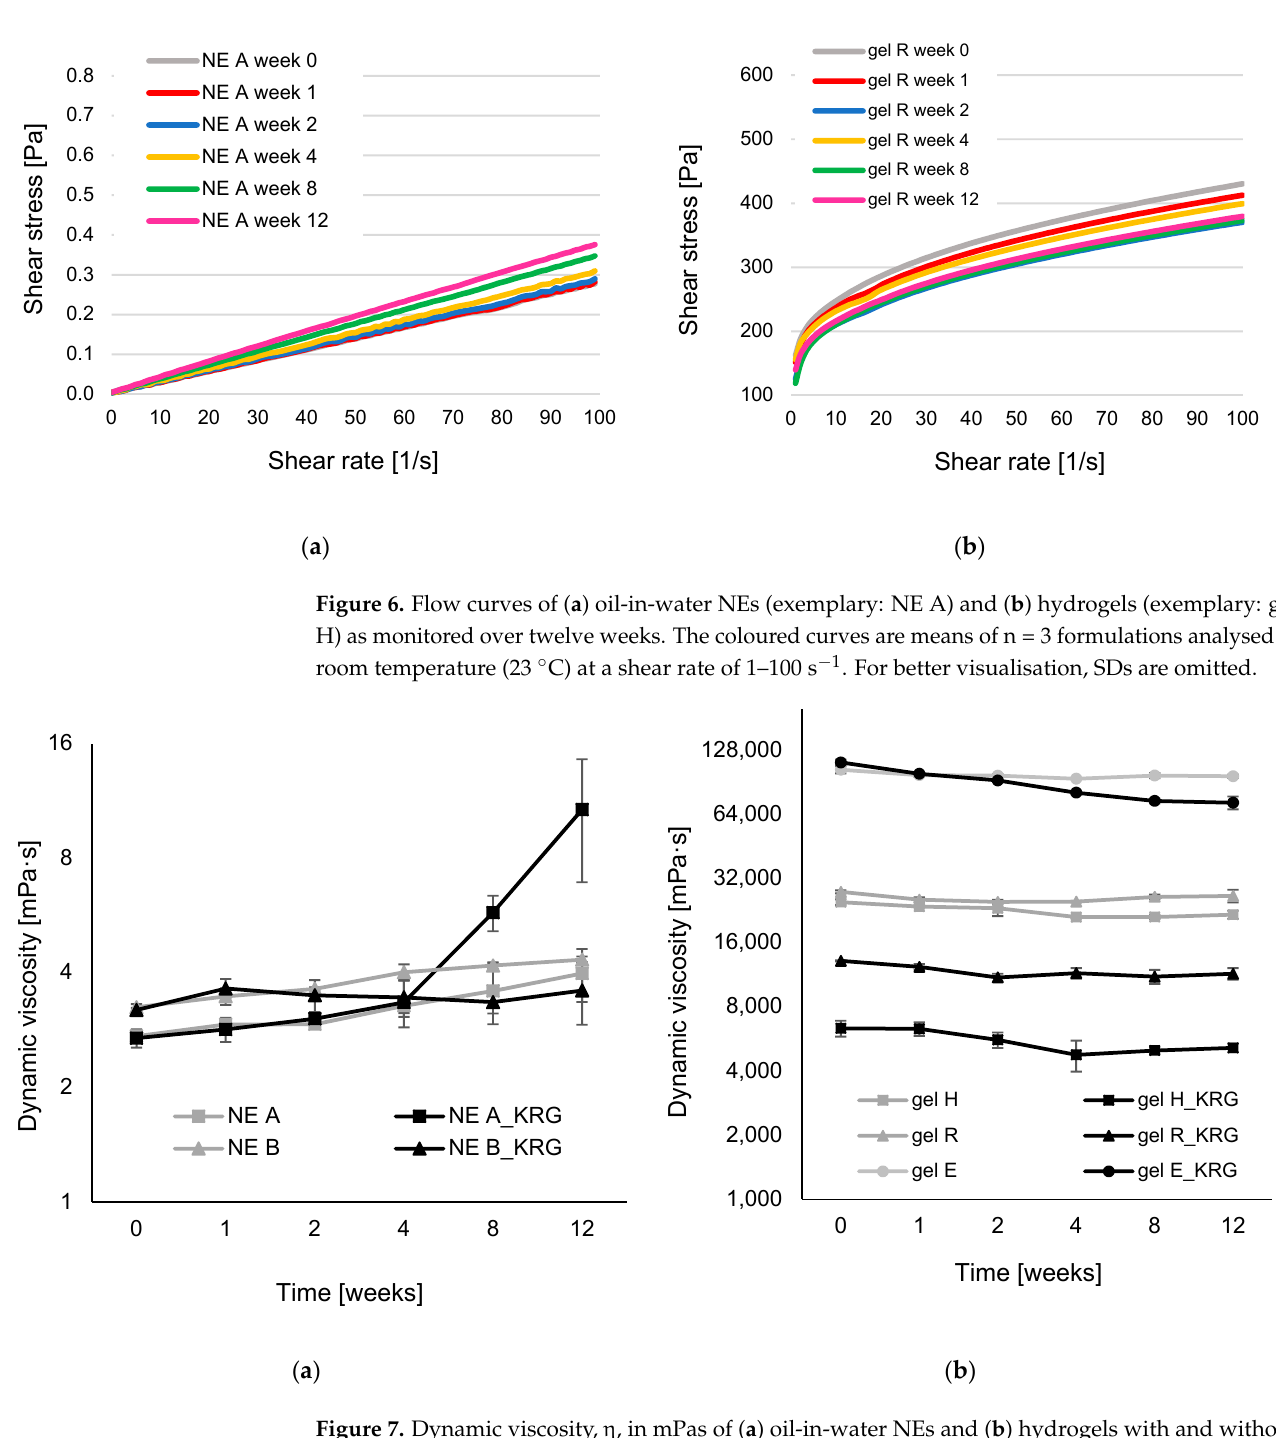
gels exhibited remarkably different flow behaviour. However, for better comparability, the same unit of measure for dynamic viscosity (mPas) was consistently used in the graphics.